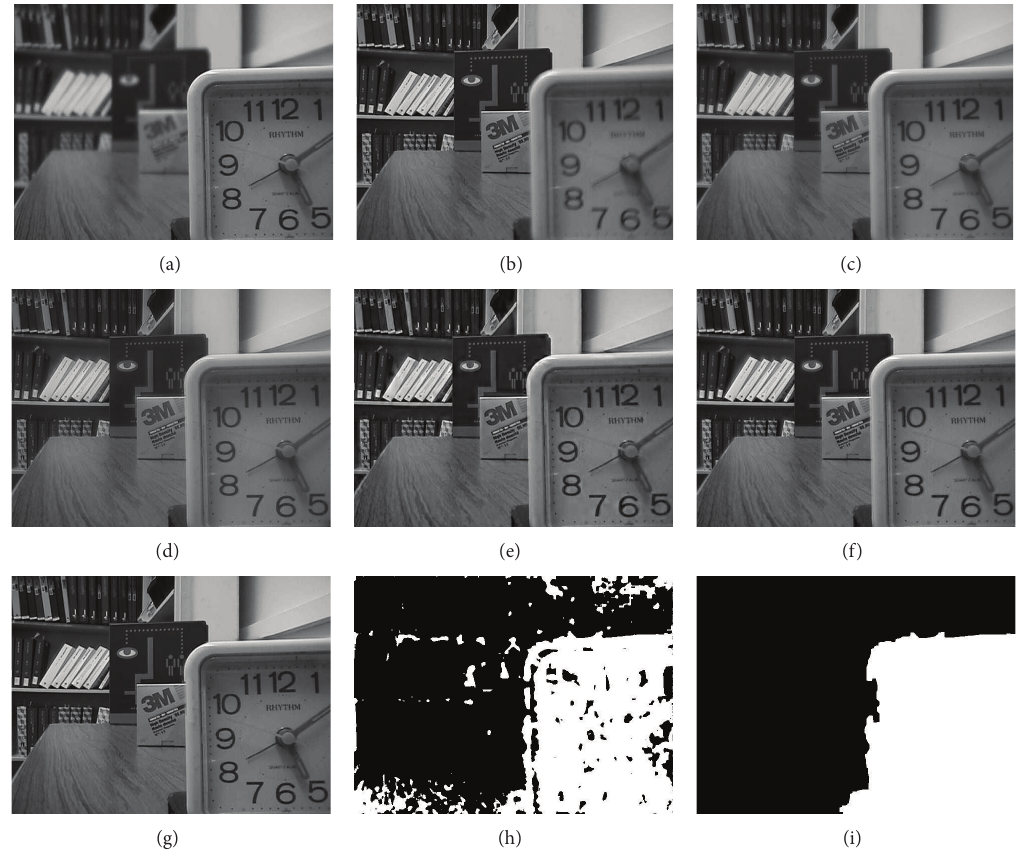
Figure 6: Original and fused image of “disk”: (a) focus on the right; (b) focus on the left; (c) fused image using average; (d) fused image using gradient pyramid; (e) fused image using DWT; (f) fused image using SIDWT; (g) fused image using the proposed method; (h) the initial focused region; (i) the modified focused